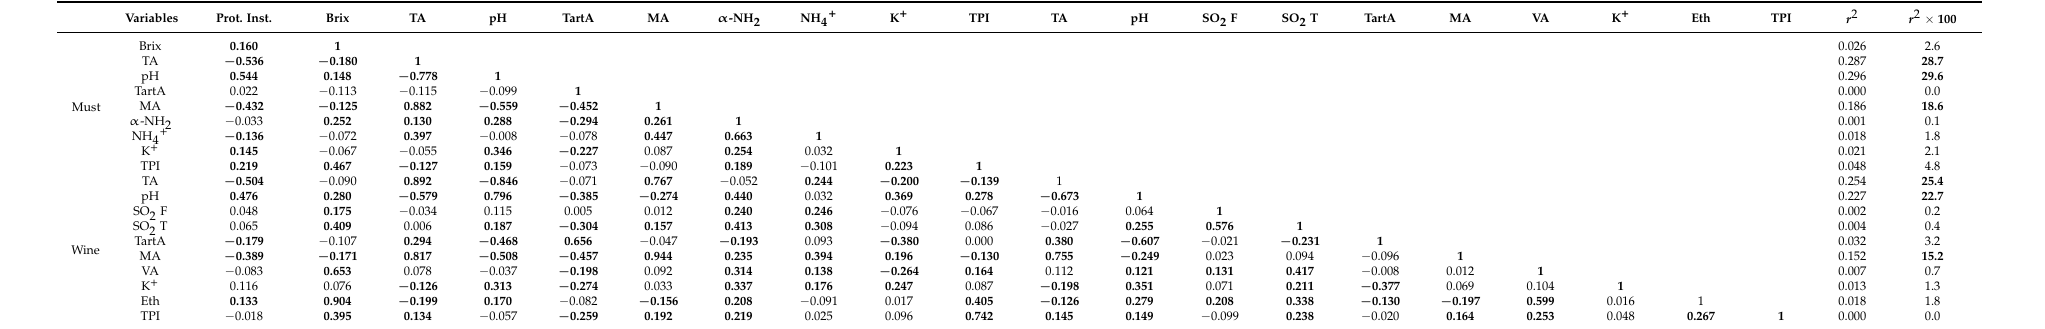
Table 3. Pearson test correlation coefficients ( r ) among the oenological parameters of white must and wine ( p < 0.05). Prot. Inst.: Proteins Instability; Brix: Sugar; TA: Titratable acidity; TartA: Tartaric acid; MA: Malic acid; α -NH 2 : Alpha-amine Nitrogen; NH 4+ : Mineral Nitrogen; K + : Potassium; TPI: Total Polyphenol Index; SO 2 F: Free SO 2 ; SO 2 T: Total SO 2 ; VA: Volatile acidity; Eth: Ethanol. In bold (Except r 2 × 100) are shown the coefficients for which a significant correlation is observed with a α = 0.05. Variables Prot.